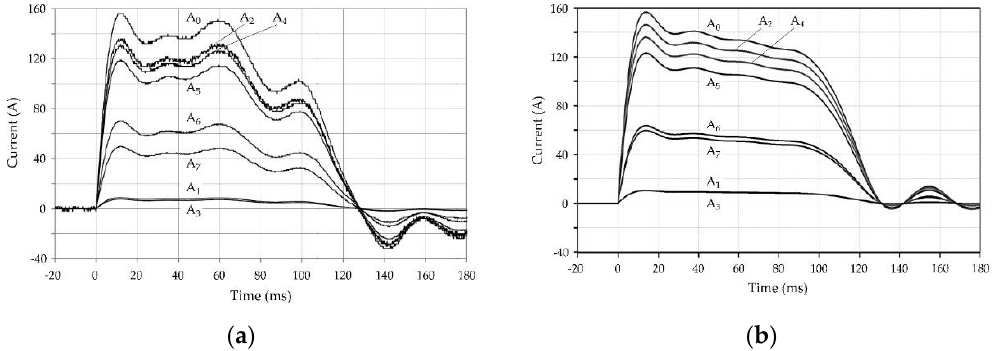
Figure 5. Waveshapes of a 120 ms-long impulse current measured in the tested object: ( a ) measured; ( b ) computed. The denotation of measuring points A 0 to A 7 is consistent with Figure 1b.